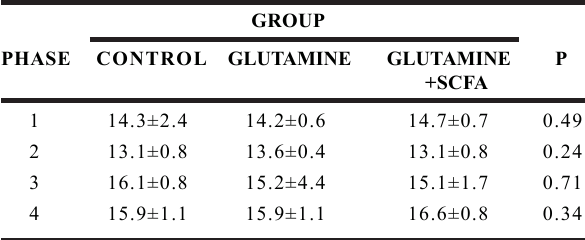
FIGURE 2 - Mean (SD) of mucosal weight in the three groups in basal condition (BC) and postoperatively (PO) at the jejunum (JEJ) and ileum (ILE). * = p < 0.01 vs. pre in each group at the jejunum. † = p < 0.01 vs. pre in each group at the ileum. GLN = glutamine group; GLN+SCFA = glutamine+SCFA